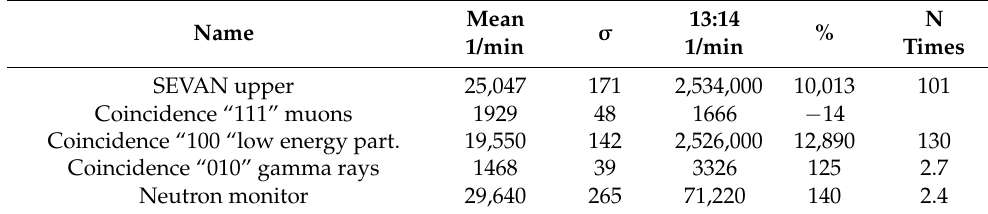
Table 4. Minute average count rates of SEVAN and NM detectors located at Lomnicky Stit and extreme values at the maximum flux minute of a TGE registered on 10 June